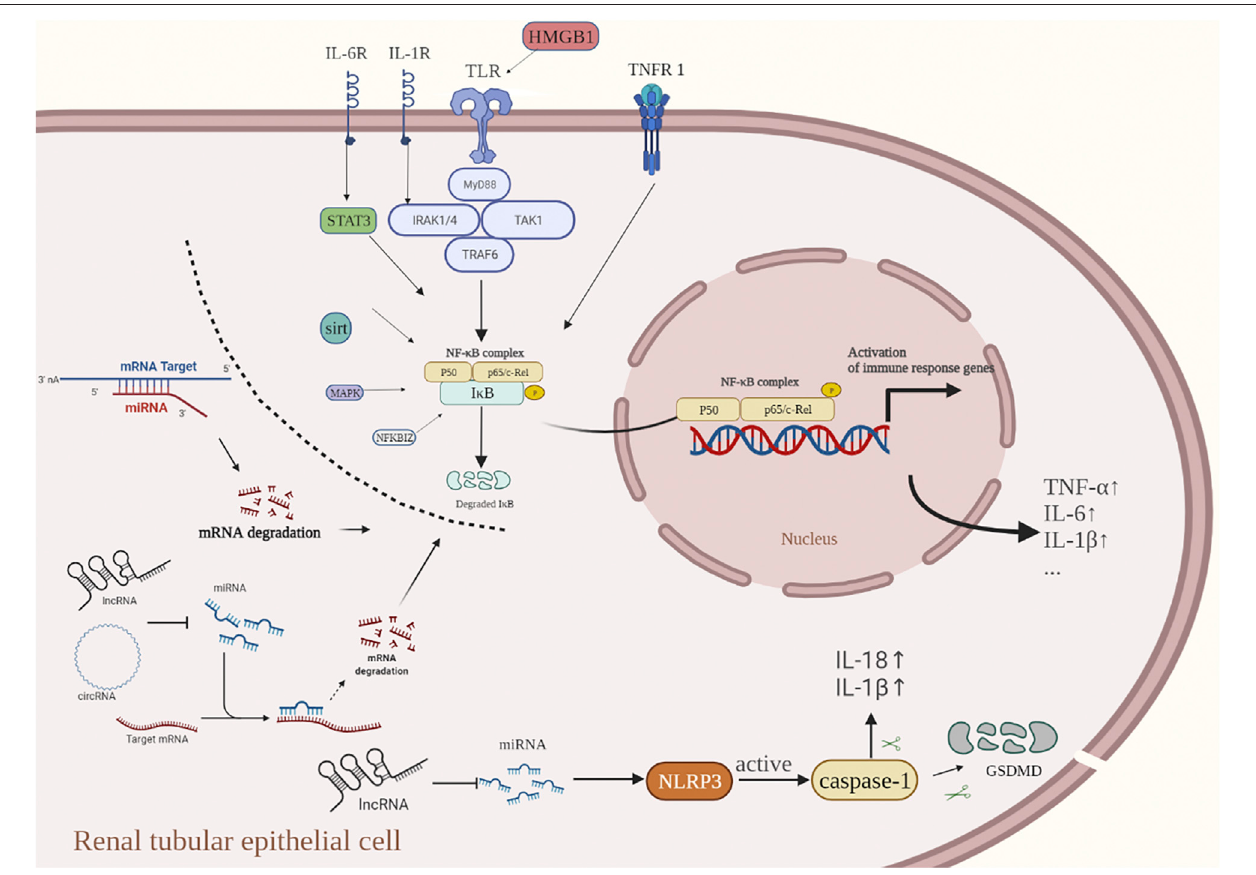
FIGURE 3| When cells are exposed to a variety ofstimuli(in fl ammatory factors, bacterial infection, oxidative stress, etc.,). I κ B fl ows through the degradation of the IKK phosphorylated proteasome, leading to abnormal NF- κ B activation and nuclear translocation, thus promoting the transcription and translation of in fl ammation- related genes. The acute in fl ammatory cytokines TNF- α and IL-1 β induce the activation of the NF- κ B signaling pathway by activating the membrane receptors TNFR-1 and IL-1R, respectively. Activation of TLR4, a receptor on the renal tubular epithelial cell membrane, can form a complex of related factors to activate the NF- κ B signal transduction pathway. SIRT1 reduces NF- κ B activity and indirectly inhibits the expression of downstream in fl ammatory cytokines. In fl ammasomes located in the cytoplasm can activate caspase-1 to release pro-in fl ammatory factors such as IL-1 β and IL-18, and fi nally produce an in fl ammatory response. The current research suggeststhatncRNAsplayanimportantroleinregulatingthein fl ammatoryresponseofAKI,andtheyareinvolvedinregulatingtheNF-KBpathwayandcellpyroptosisat the transcription level, thus regulating the in fl ammatory response. In the in fl ammatory response of AKI, ncRNAs usually work in the following ways: 1) miRNA directly targetsthe3 ′ -untranslatedregion(3 ′ -UTR)ofthetargetmRNAtoinhibittranscription;2)lncRNAsandcircRNAs,commonlybinddirectlytomiRNAsthroughcompetitive endogenous RNAs (ceRNAs) that promote up-regulation of target mRNA